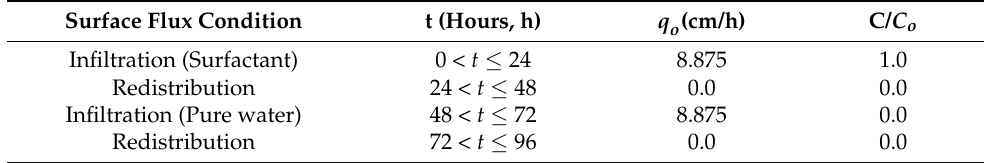
Table 2. Applied intermittent flux boundary